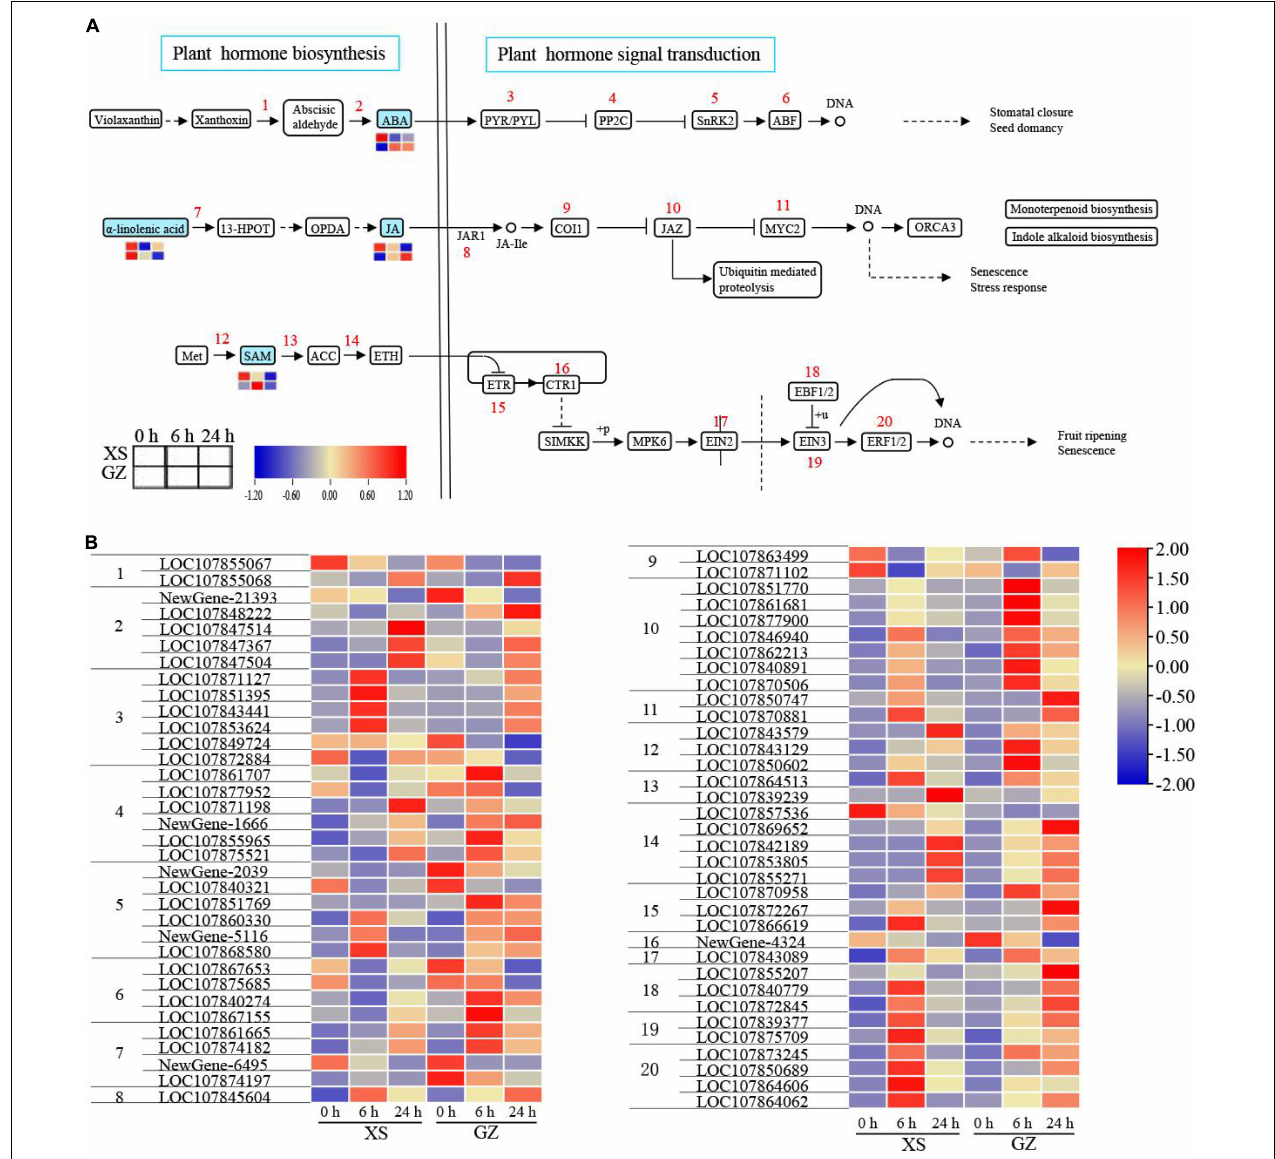
FIGURE 6 | Adaptive changes involved in plant hormone biosynthesis and plant hormone signal transduction in cold-sensitive cultivar XS and cold-tolerant cultivar GZ under cold stress. (A) Metabolic changes in XS and GZ under cold stress. (B) Transcriptional changes of the genes in XS and GZ under cold stress. Each graph represents the normalized intensity of corresponding metabolite or genes in different sampling